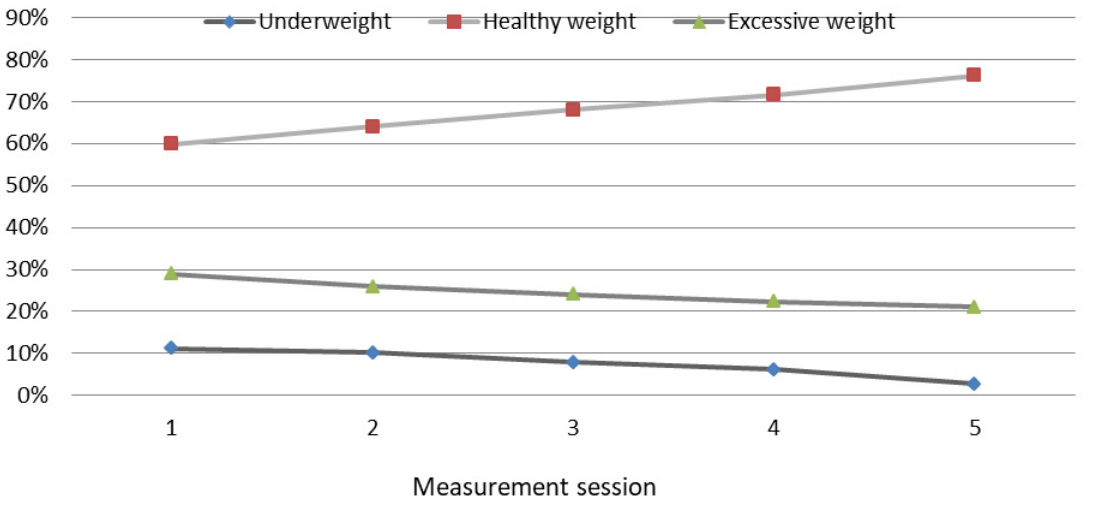
Figure 3. Changes in the body fat content categories in SC children during the course of the study. Excessive weight—overweight and obesity. Changes in the fat mass % categories in SC children during the course of the study.